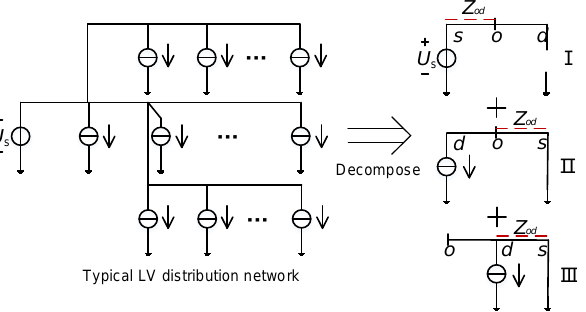
Figure 4. The typical LV radial distribution network and circuit decomposition.